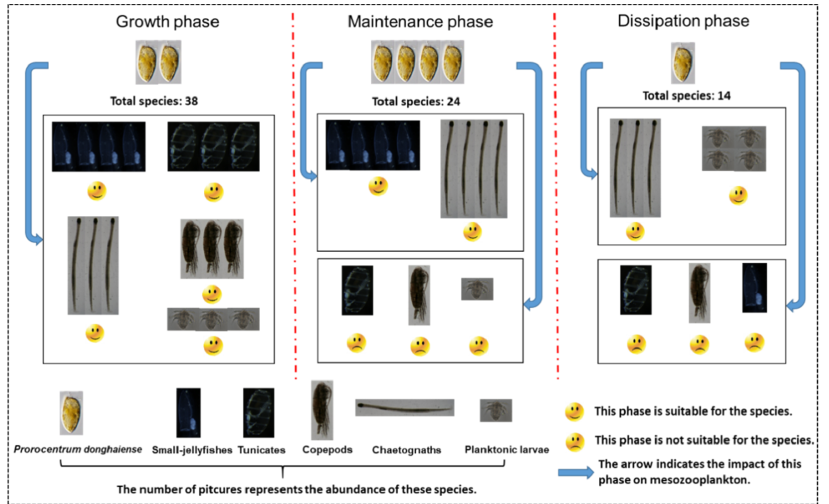
Figure 9. Responses of zooplankton community structure in relation to different phases of P. donghaiense bloom.